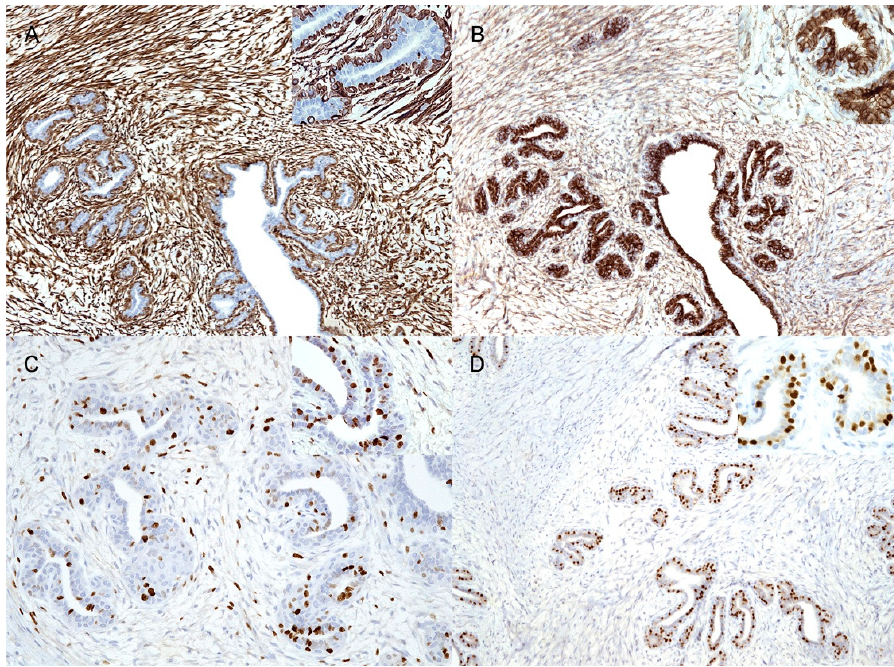
Figure 3. Immunohistochemical features of feline mammary fibroadenoma. ( A ) Stromal cells and basally located elongated ductal and tubular cells showing diffuse cytoplasmic positivity for vi ‐ mentin (10×). Inset: higher magnification (40×); ( B ) Membrane/cytoplasmic positivity for β‐ catenin in neoplastic ducts and tubules as well as in the stroma (10×). Inset: higher magnification (40×); ( C ) Nuclear Ki67 immunoreactivity observed in both epithelial and stromal elements (20×). Inset: higher magnification (40×); ( D ) Nuclear ER ‐ ⍺ positivity restricted to neoplastic ductal and tubular cells (10×). Inset: higher magnification